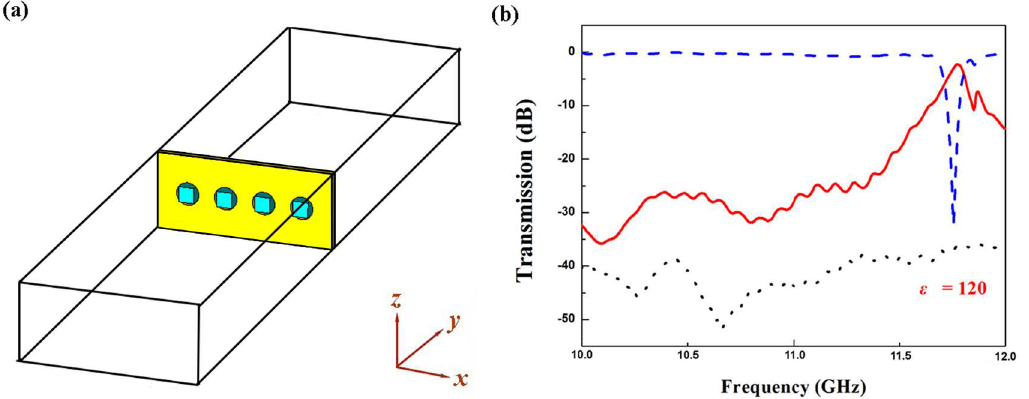
Fig 5. Schematic diagram of the experimental setup and measuredtransmission apectra for the microwave bandpass filter structure. (A) Schematic diagramof the experimental setup; (B) Measuredtransmission spectra for the microwave bandpass filter structure when ε = 120 (red lines), metallic apertures (black lines) and dielectricparticles array without metallic plate (blue lines),